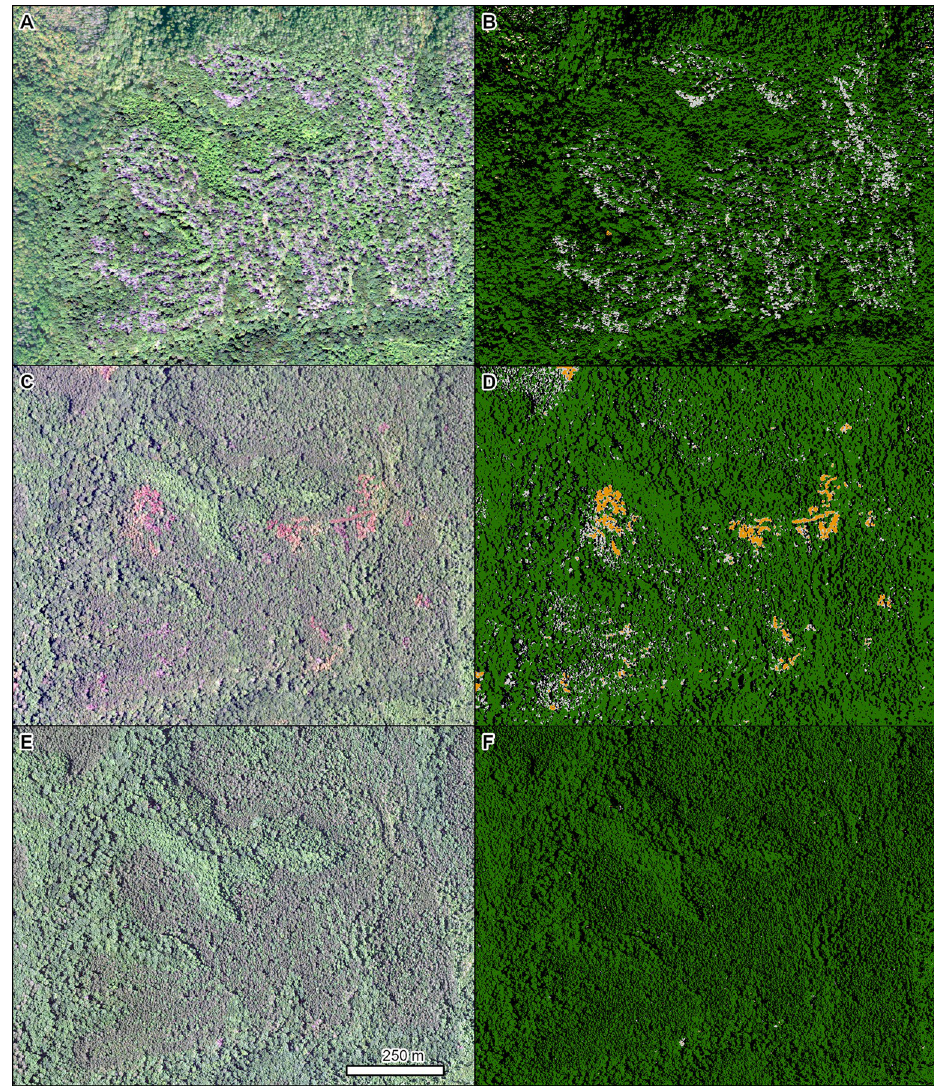
Fig 8. Mortality in a mixed stand of mostly loblolly pine ( Pinus taeda L.) caused by southern pine beetle ( Dendroctonus frontalis ). Left panels are NAIP imagery from 2019 (A), 2017 (C), and 2015 (E). Right panels (B, D, F) are the corresponding TCH model results from each year (orange = red crowns, light gray = gray crowns, dark green = green crowns, black = shadowed crowns). Location: William B. Bankhead National Forest in northern Alabama. Insect and Disease Survey database DAMAGE_AREA_ID: {d9b4b4b9-855f-4a9f-9d87-87b7c95c211e}. NAIP imagery (public domain) provided by USDA-FSA-APFO.